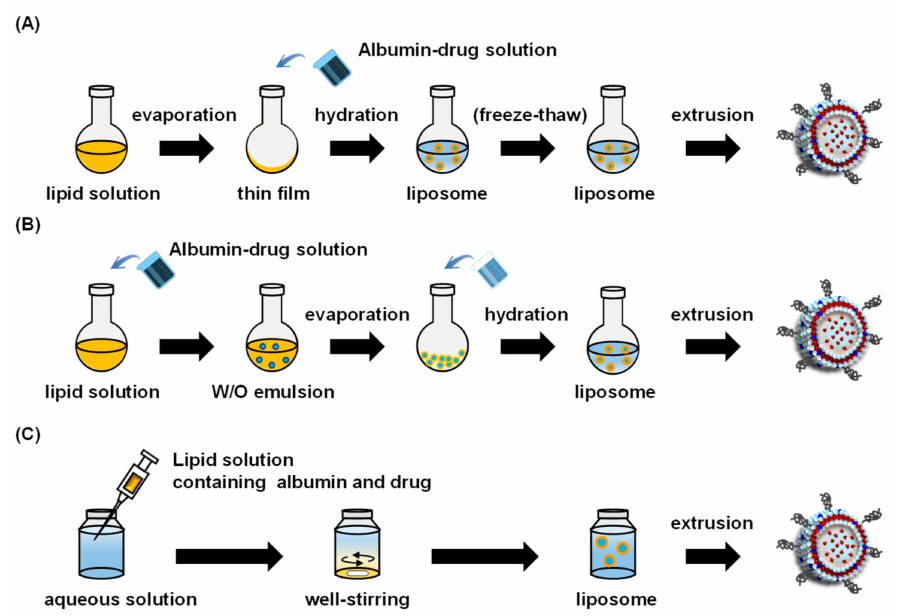
Figure 4. Scheme for the preparation of albumin-encapsulated liposome by thin-film hydration method ( A ), reverse-phase evaporation method ( B ), and ethanol injection method ( C